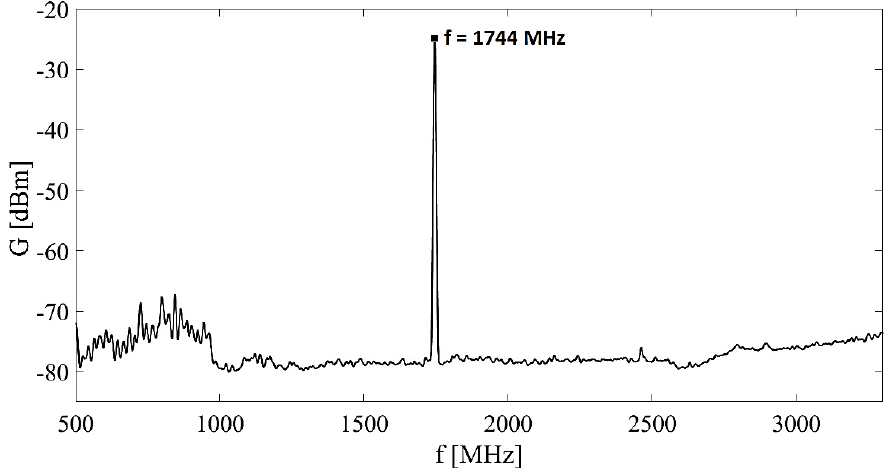
Figure 9. Experimental results: EM field received power spectrum in region of interest.